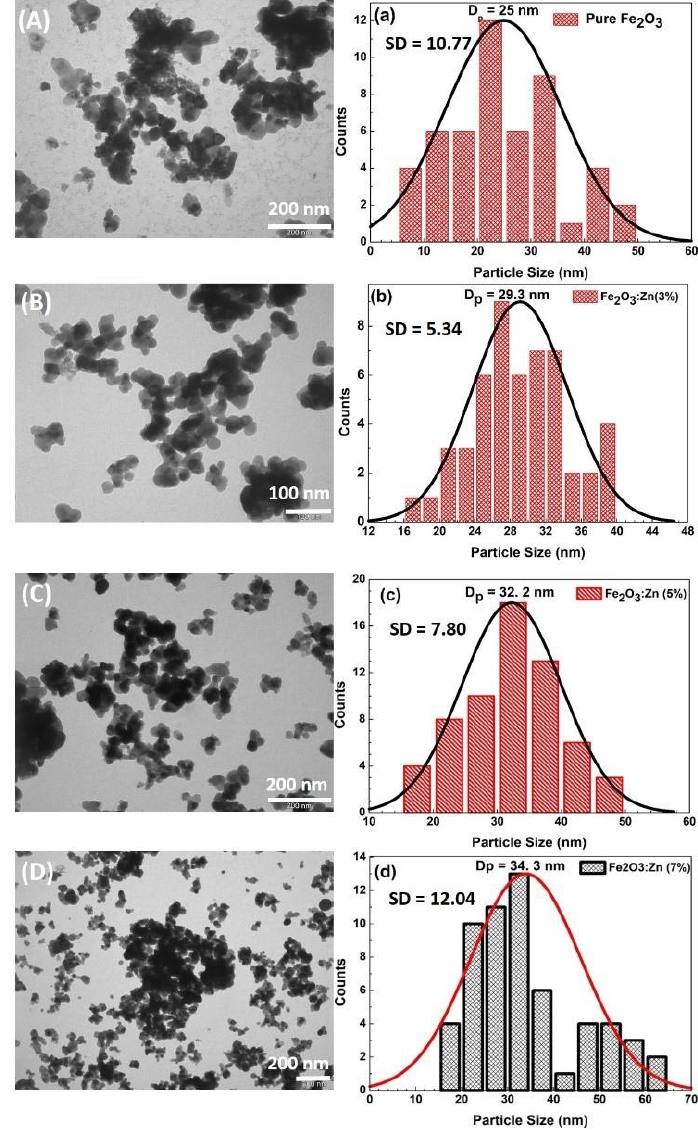
Figure 4. Micrographs recorded by TEM and their particle size distribution curve: ( A , a ) pure Fe 2 O 3 ; ( B , b ) 3% Zn− doped Fe 2 O 3 ; ( C , c ) 5% Zn− doped Fe 2 O 3 ; and ( D , d ) 7% Zn− doped Fe 2 O 3 .